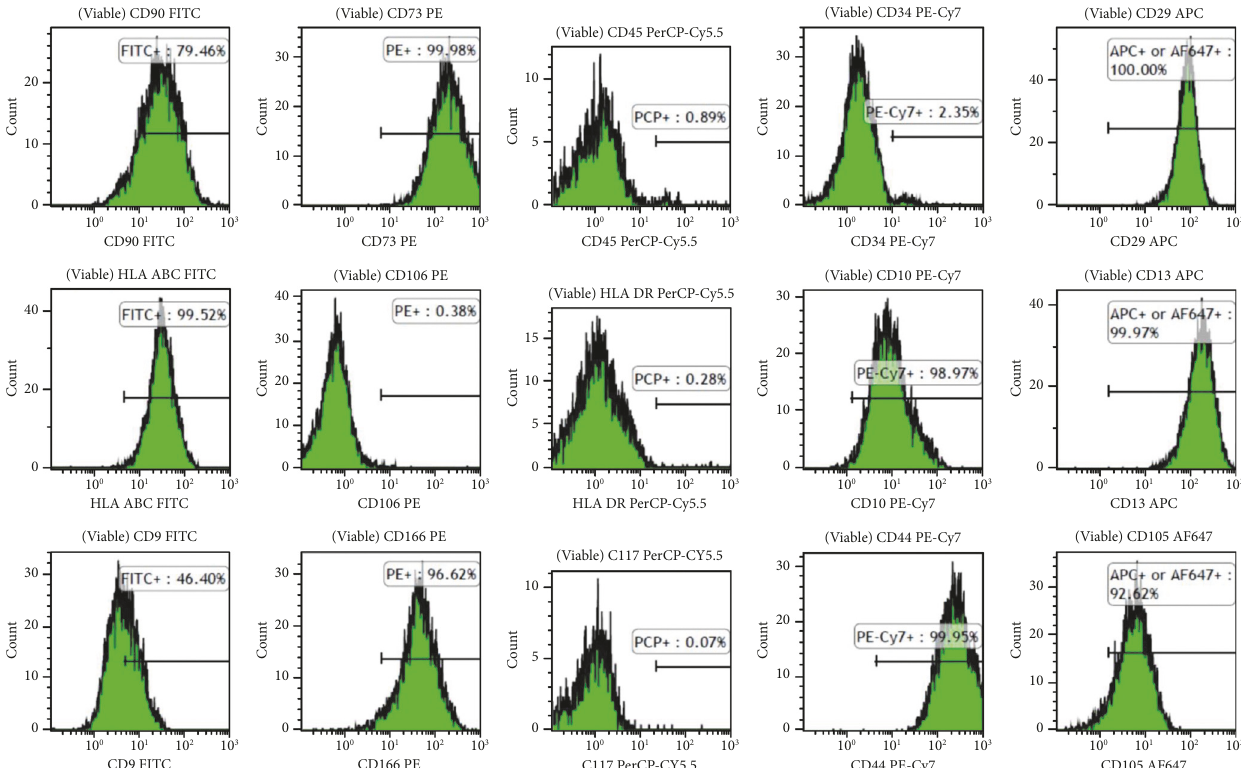
Figure 3: Flow cytometry analysis for hAFMSCs. hAFMSCs used for the current experiments that expressed surface markers as the percentage of viable singlets gated showed 100% CD29, 79.5% CD90, 0.9% CD45, 100% CD73, 2.4% CD34, 100% CD13, 99.5% HLA-ABC, 0.3% HLA-DR, 0.4% CD106, 99%, CD10, 92.6% CD105, 46.4% CD9, 0.1% CD117, 96.6% CD166, and 99.9%